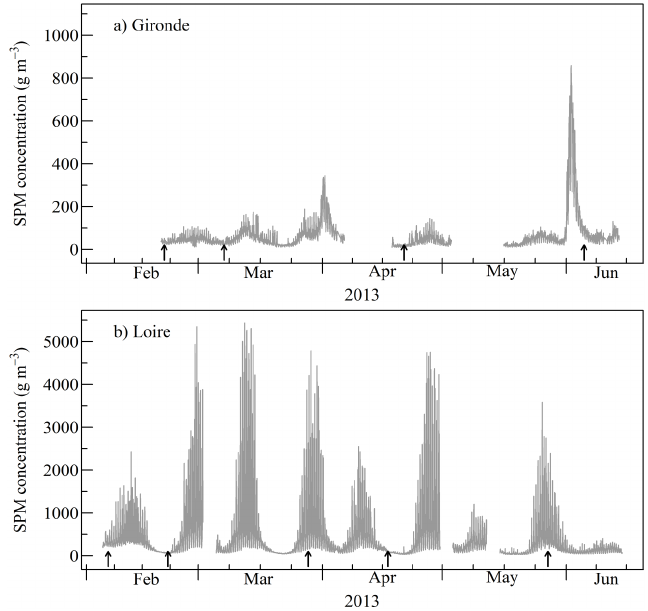
Figure 3. ( a ) Suspended particulate matter (SPM) concentration measured using automated turbidity station in the Gironde estuary at Bordeaux; ( b ) SPM concentration measured using automated turbidity station in the Loire estuary at Donges. Vertical arrows show the dates of partially cloud free SPOT4 (Take5) images listed in Tables 2 and